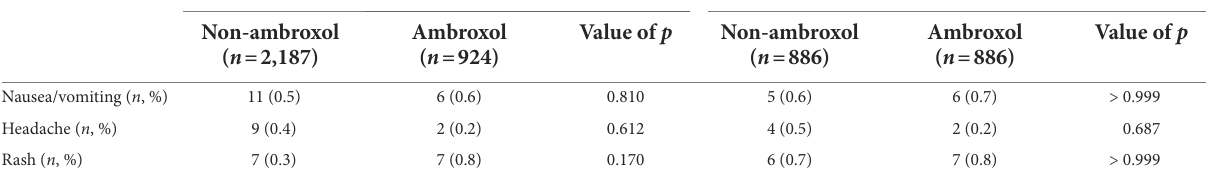
TABLE 3 Safety outcomes and adverse